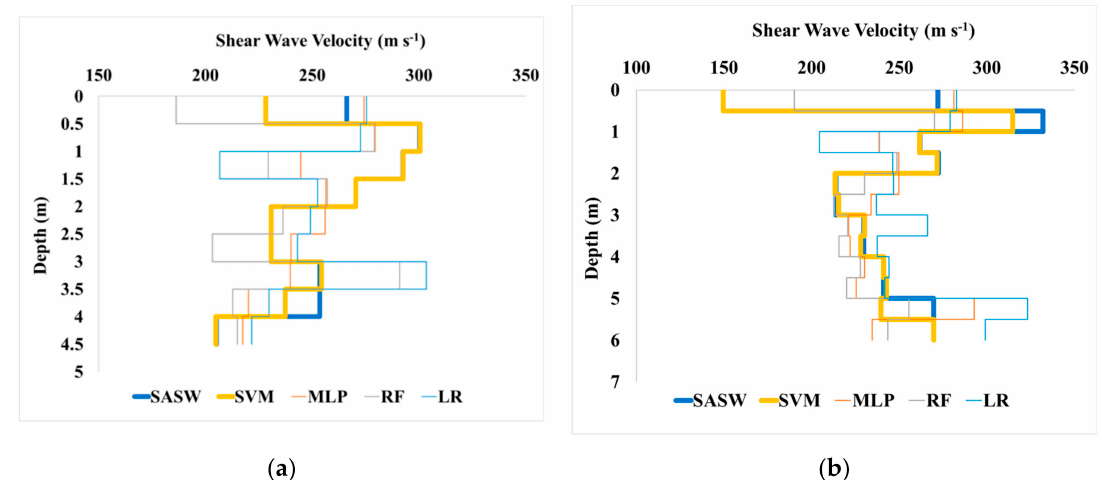
Figure 15. V S profiles from SASW inversion and ML algorithms for ( a ) test 5 and ( b ) test 6.